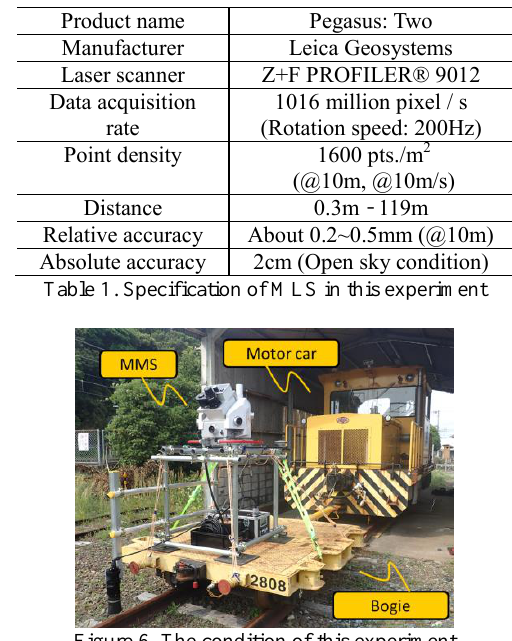
Figure 6. The condition of this experiment